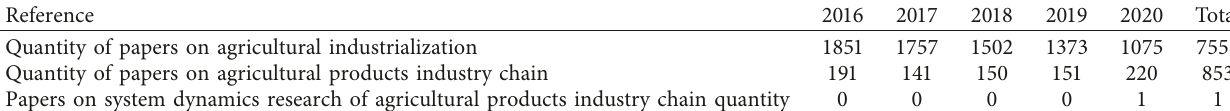
Table 1: Research on the number of papers.